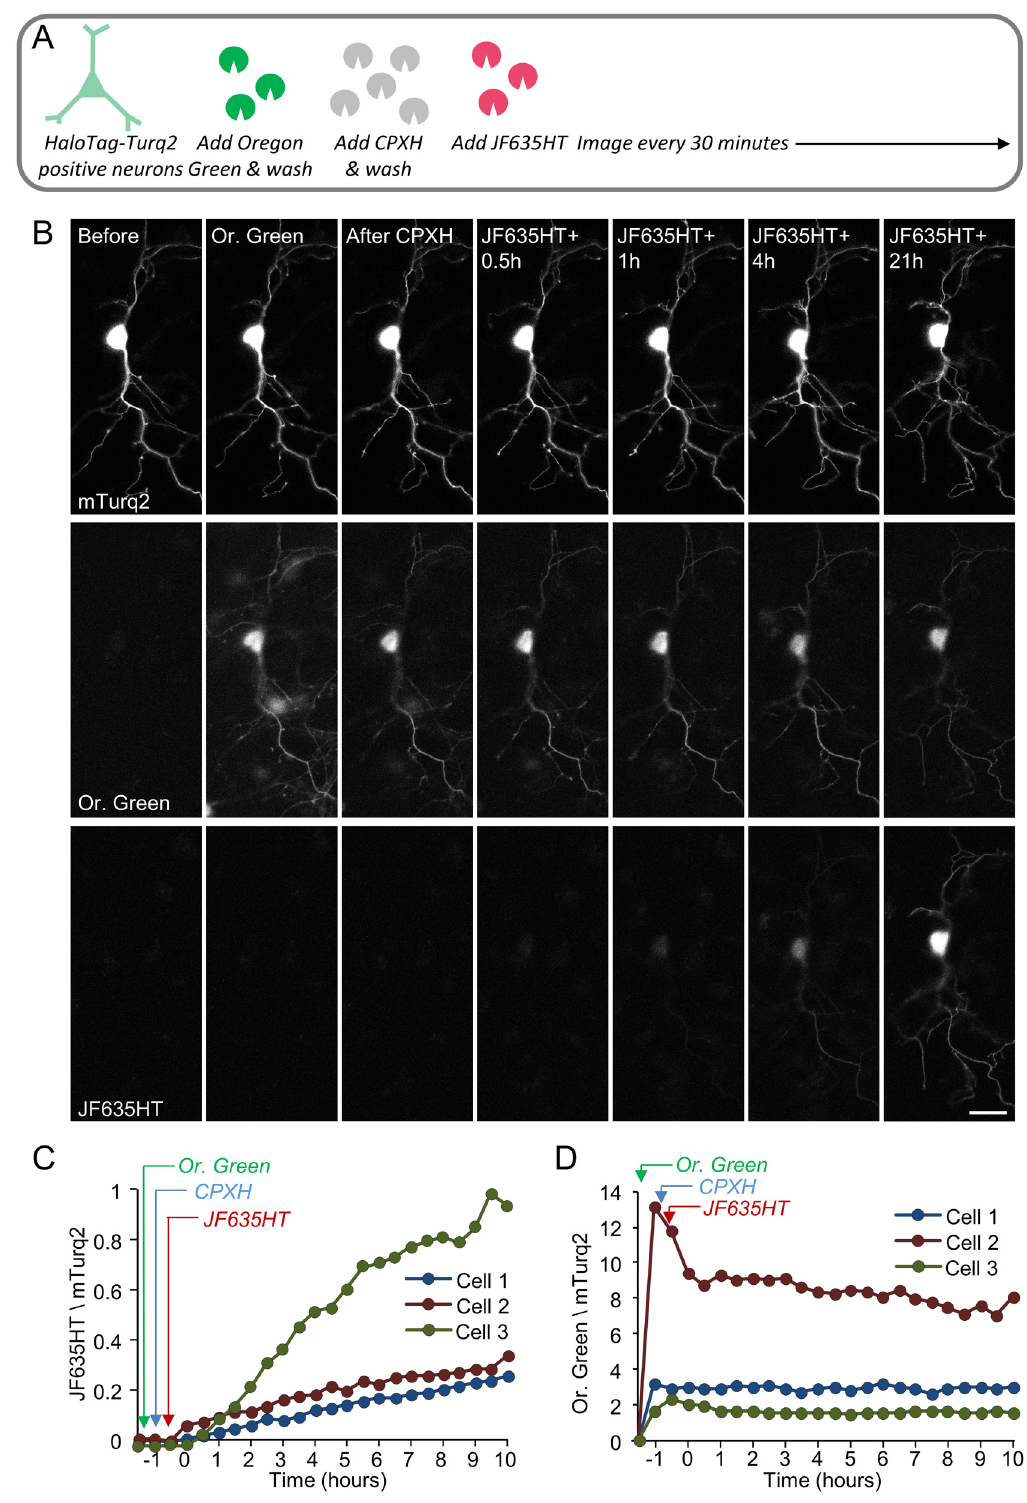
Figure 6. Dual-color labeling time-lapse of neurons expressing HaloTag-mTurq2. ( A ) Neurons expressing HaloTag-mTurq2 were labeled with Oregon Green ligand (Promega 1 µM, 30 min), washed, and blocked with CPXH (10 µM) for 30 minutes. The cells were then washed and labeled with JF635HT and followed by time-lapse imaging. ( B ) Example of mTurq2-positive cortical neuron (14 days in culture) treated as described in A and followed by time lapse imaging. Bar, 20µm. ( C ) Changes in JF635HT, and ( D ) Oregon Green labeling over time were quantified by measuring, on a cell-by-cell basis, the ratio of JF635HT (or Oregon Green) to mTurq2 fluorescence in mTurq2-positive cells. Background corrected fluorescence ratios for three neurons are shown. Images in B belong to Cell 1.